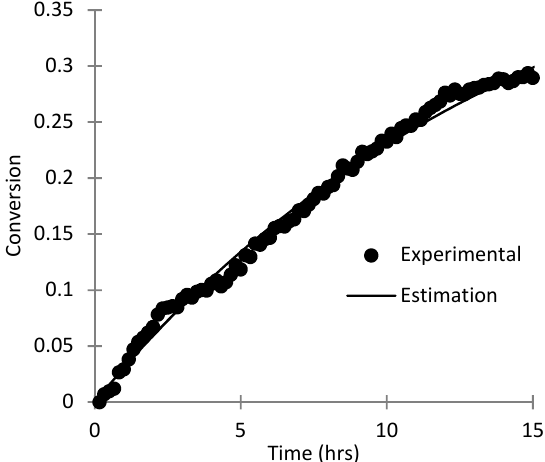
Figure 9. Monomer conversion profiles for the homopolymerization of SHMeMB at 75 °C with 1 wt % V-86 and 30 wt % monomer. The solid line represents the estimated conversion profile using parameter estimation.